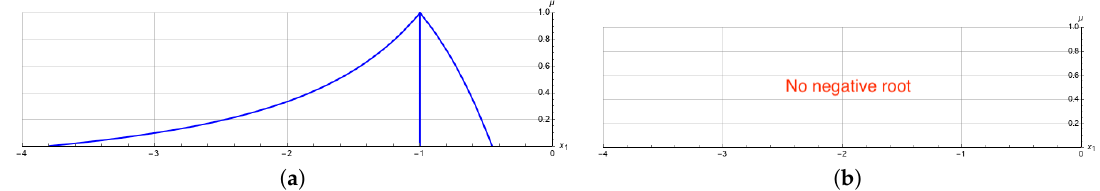
) of the negative multidimensional solution (root) of the benchmark (9) Figure 6. The span function s ( x gr 1 determined using MF-arithmetic ( a ) and solution found with a standard approach based on